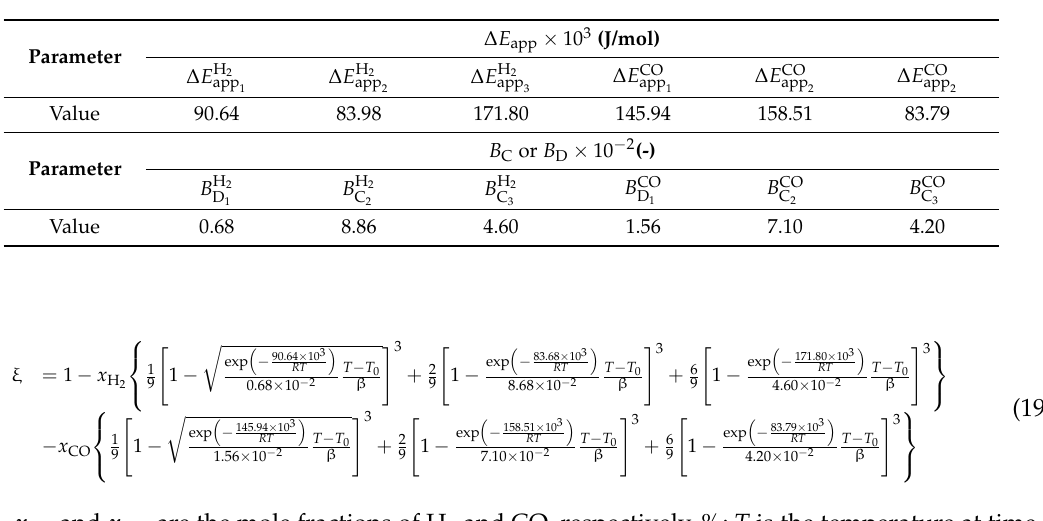
Table 4. The kinetic parameters for the non-isothermal reduction model for HCVTM pellets by gas